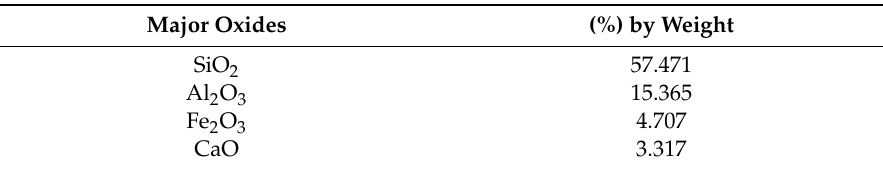
Table 4. Chemical composition of fly